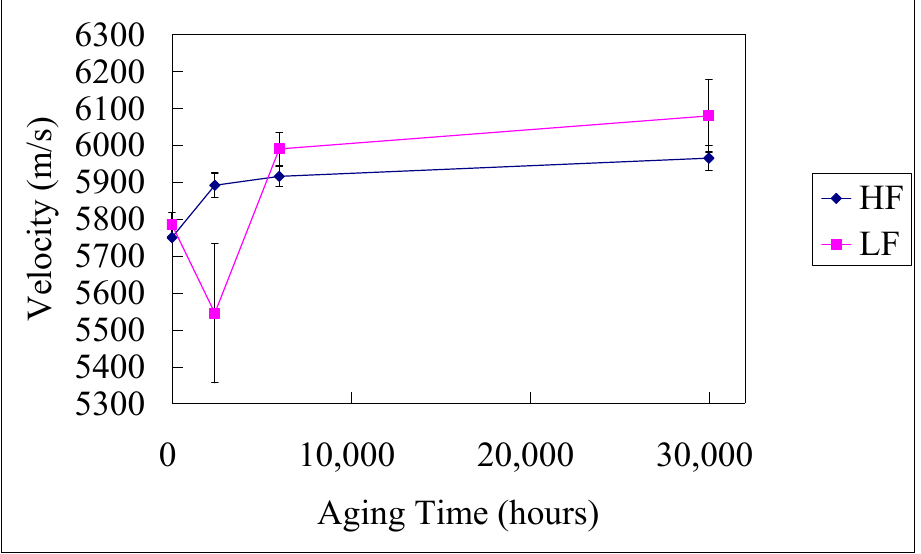
Figure 11. Variation of velocity with aging time.